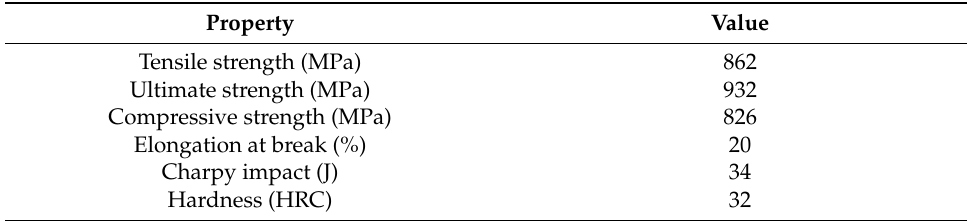
Figure 1. Experimental setup and schematic of the machining operation. ( a ) Experimental setup; ( b ) schematic of machining operation. Table 1. Properties of the plastic mold steel AISI